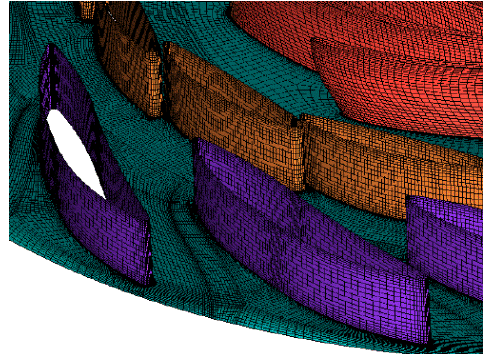
Figure 7. Definition of the damping ratio of torsional self-excited vibration.